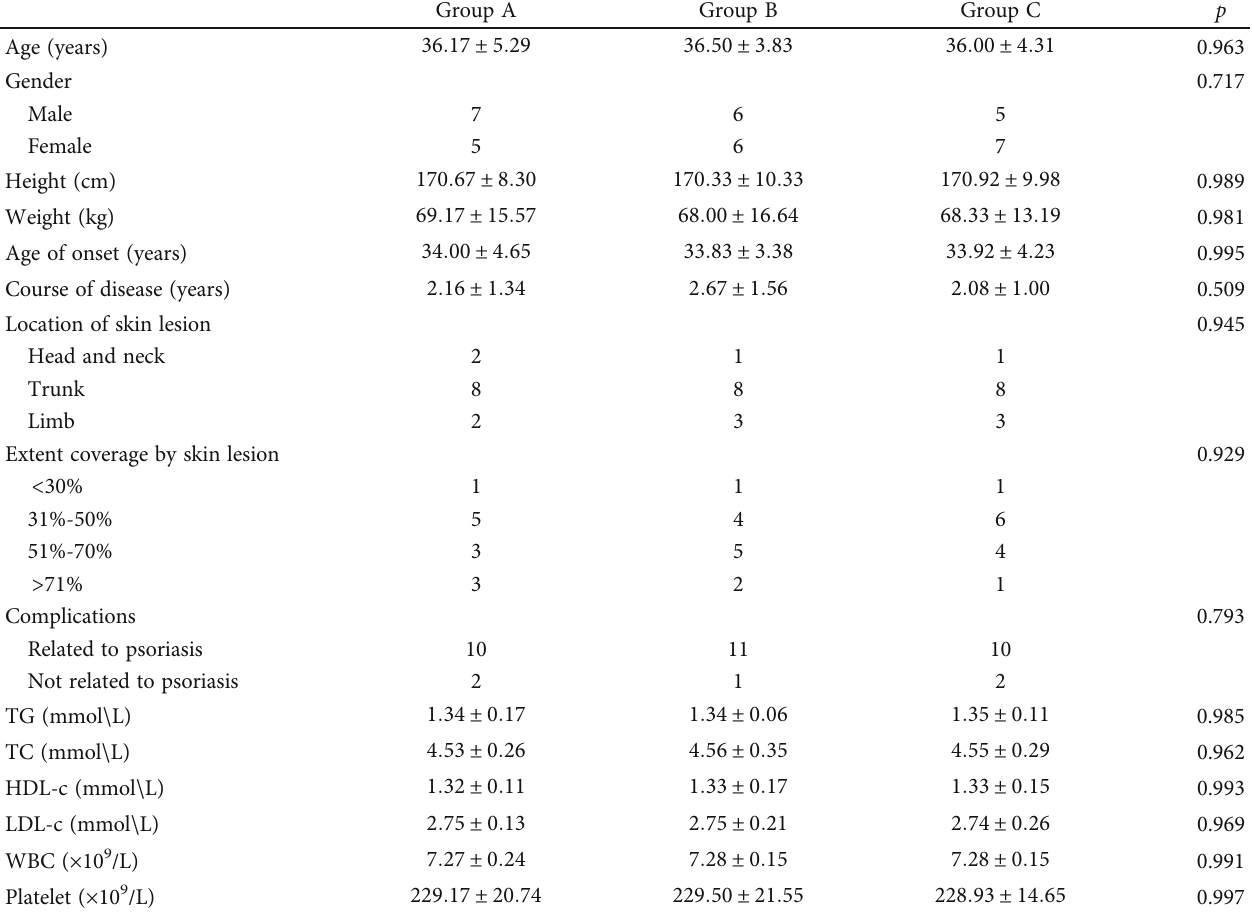
Table 1: General information of the patients in the three